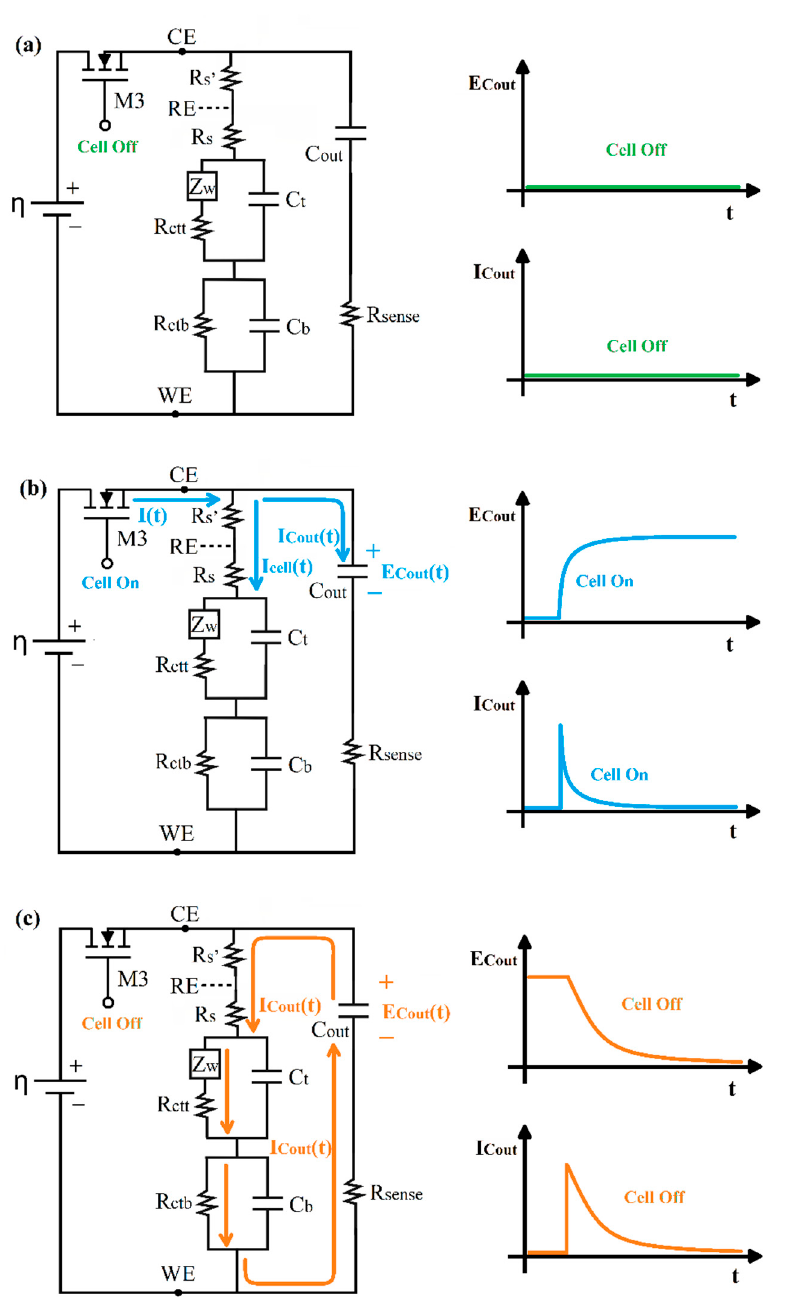
Figure 3. Proposed electrical diagram to determine the current relaxation: ( a ) external capacitor discharged and double layer in equilibrium; ( b ) external capacitor and double layer charging stage; ( c ) external capacitor and double layer discharging stage.